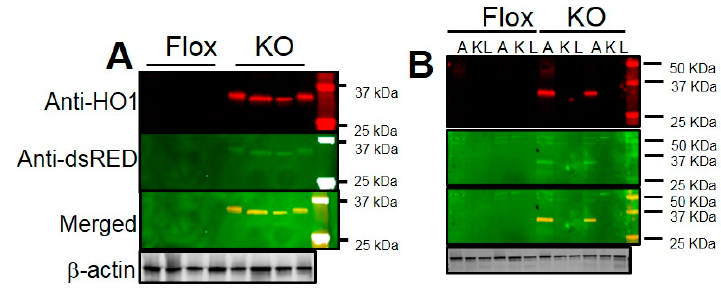
Figure 6. ( A ) Representative Western blot from adipose tissue of male Flox and KO mice after 30 weeks of high-fat diet (HFD); ( B ) Representative Western blot from of male Flox and KO mice adipose tissue (A), kidney (K), and liver (L) of Flox and KO mice after 30 weeks of high-fat diet with the anti-HO-1 antibody ( Red ) or anti-RFP ( dsRed ) antibody ( Green ) as well as merged image showing each antibody detects the same band in the adipose but not kidney and liver of KO mice. Levels of β -actin demonstrate equal loading of samples.